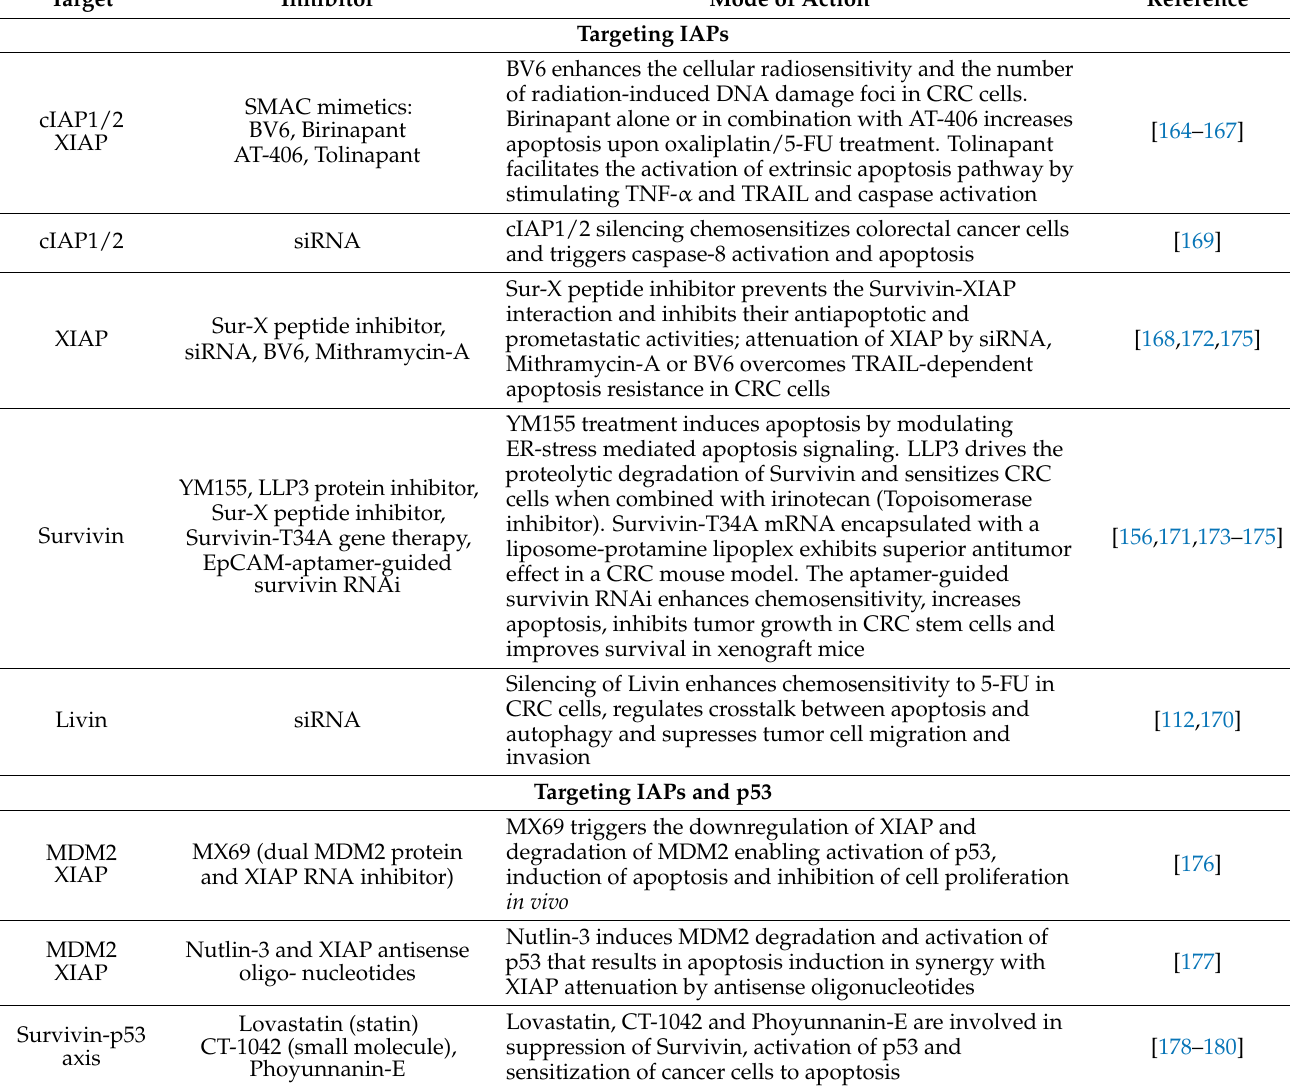
Table 1. Recent preclinical studies targeting inhibitor of apoptosis proteins (IAPs) in colorectal cancer